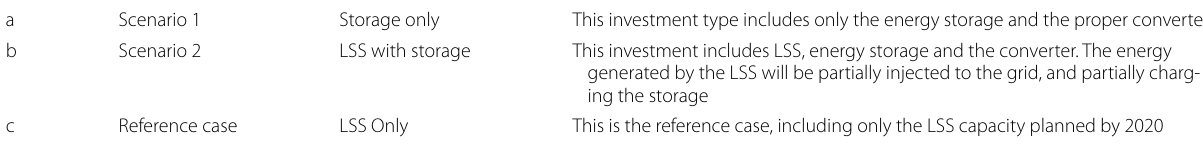
Table 2 Description of the different investment types to be compared in the economic